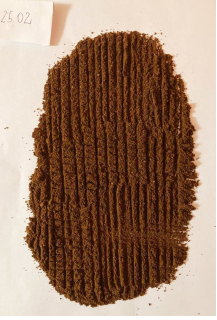
Figure 20. Coffee beans ground for about 25 s.